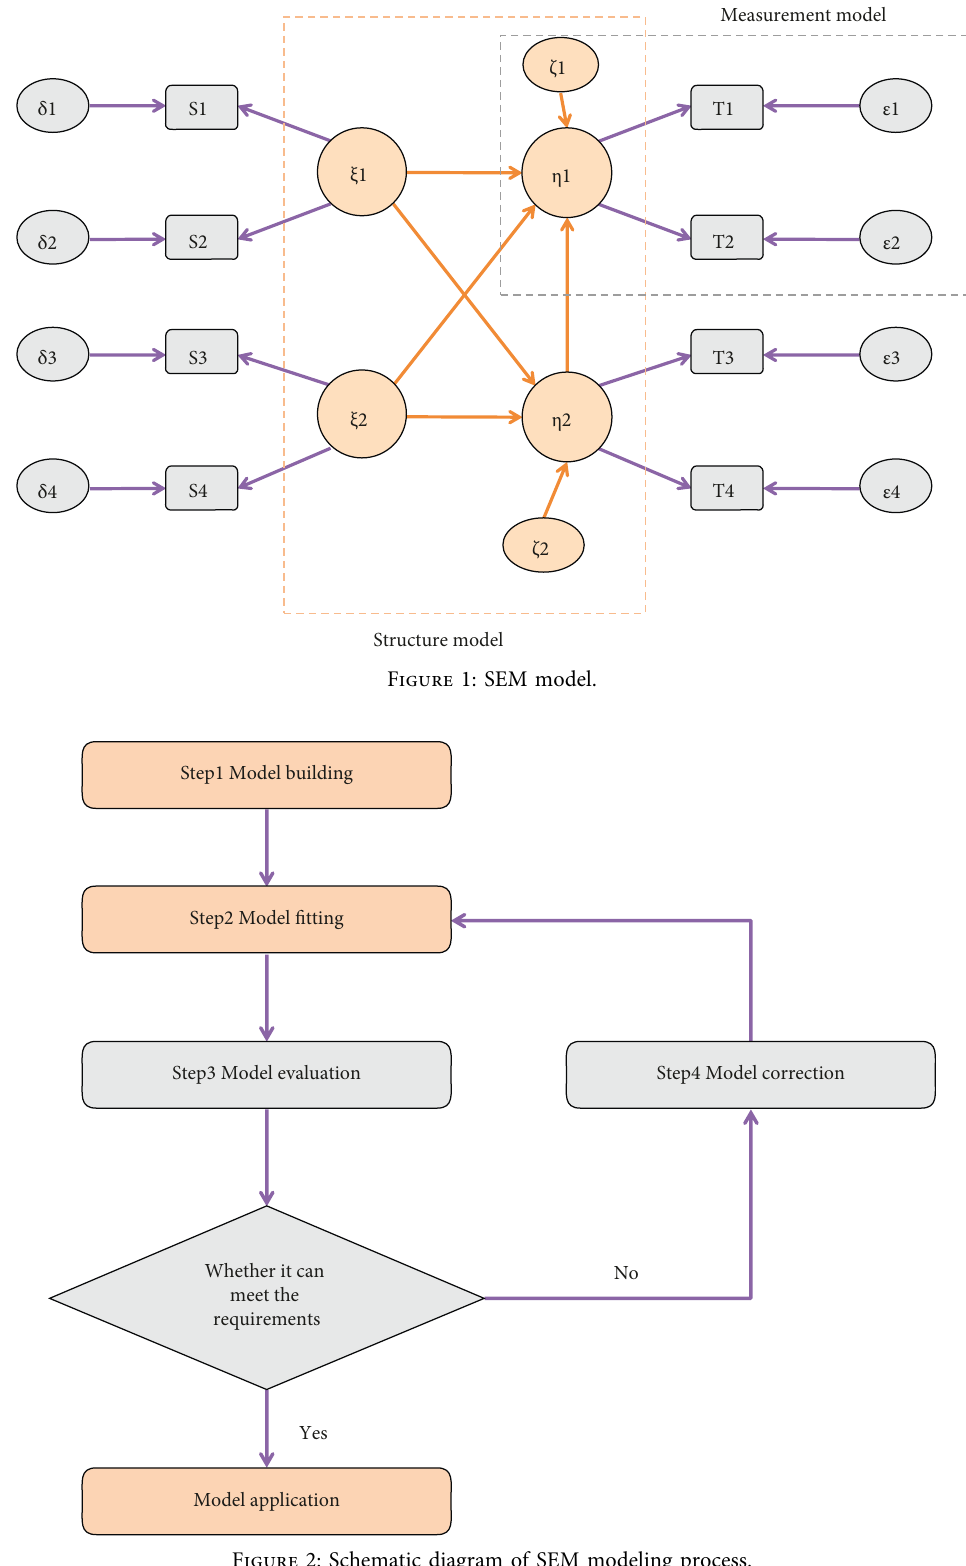
Figure 2: Schematic diagram of SEM modeling